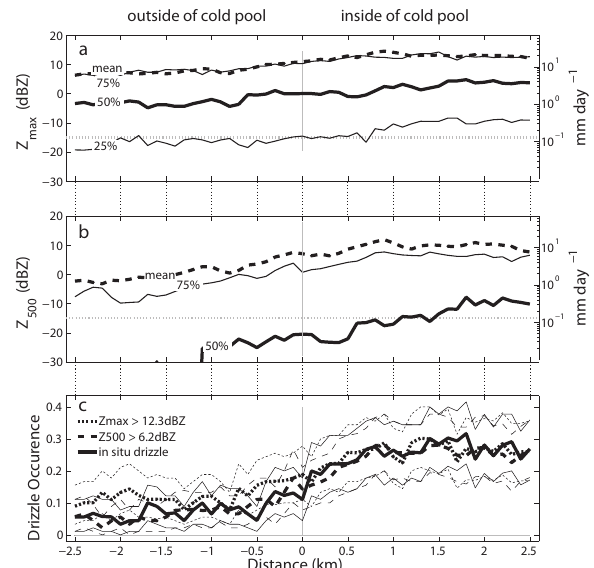
max ), (b) reflectivity at 500m ( Z 500 ), (c) the occurrence of subcloud 98th percentile precipitation rates across the cold-pool edge at each of the three different levels: at altitude of Z max (dotted), at 500m (dashed), and at flight level (solid). For ( a and b ), dotted lines indi- cate mean values, bold solid lines indicate median values, and thin solid lines indicate 25th and 75th percentile values. The 25th, 50th, and 75th percentile values are shown instead of the mean and the 95% confidence intervals, since the radar reflectivity does not fol- low a Gaussian distribution. This can be easily noted from the mean reflectivity (dashed) lying far above the median value (solid bold). Previously used − 15dBZ threshold for drizzle occurrence is noted by a dotted gray line. In (c) , the mean values and the 95% confi- dence interval are calculated using bootstrap resampling (Efron and Gong, 1983) of the mean occurrence over 1000